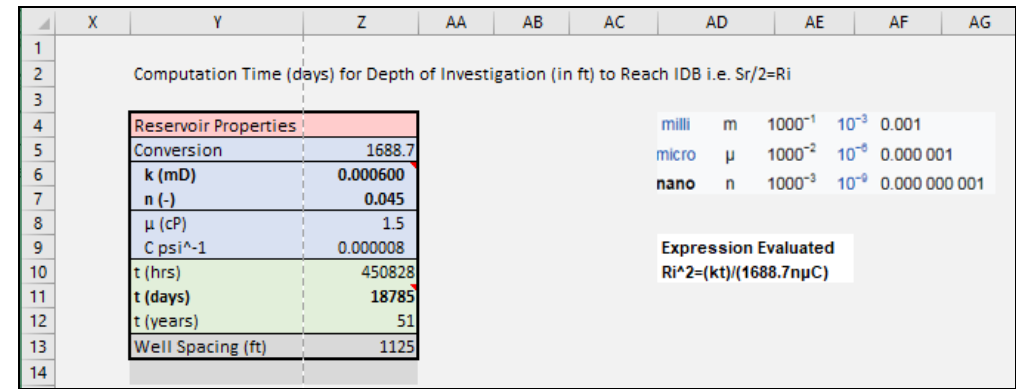
Figure A4. Input cells for reservoir properties in the “Down - spacing ratio” tab.